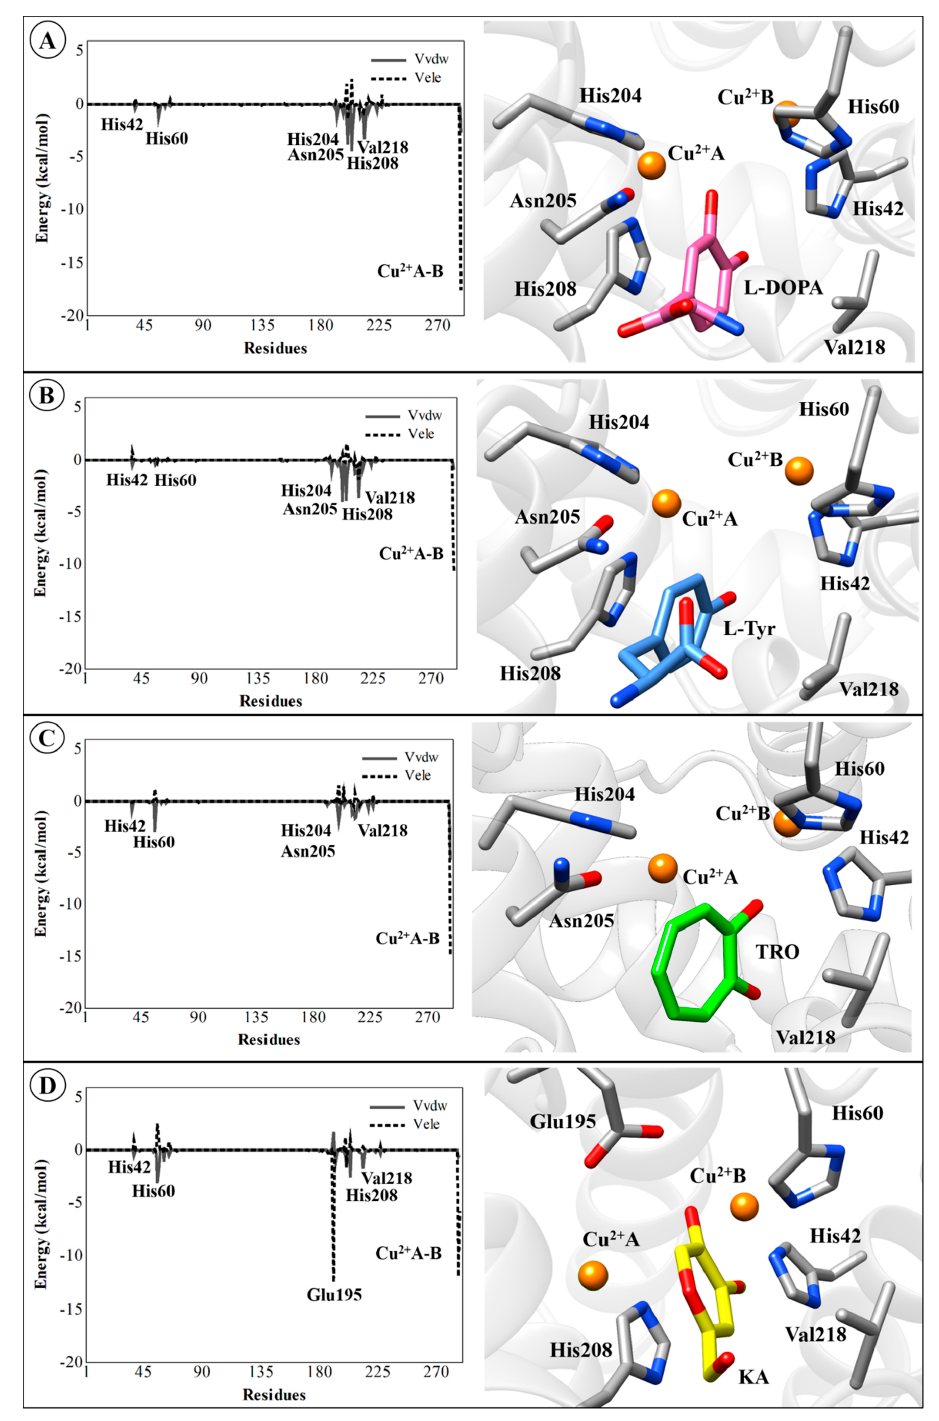
Figure 9. Average ligand–residue interaction energies (in kcal/mol) overall in compounds used in the linear interaction energy (LIE) calculations for the residues that contribute most to the ligand-surrounding electrostatic (dashed line) and (solid line) Van der Waals. ( A ) TYR Bm - l -DOPA, ( B ) TYR Bm - l -Tyr, ( C ) TYR Bm -TRO, ( D ) TYR Bm -KA. The 3D structures of this figure are available in Protein Data Bank (PDB) format in the Supplementary Materials (see Figure